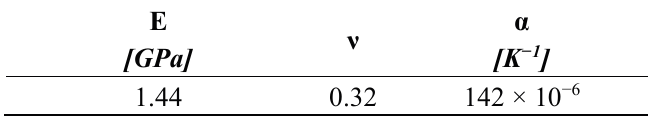
Table 2. Mechanical and thermal properties of Ormocer ® .